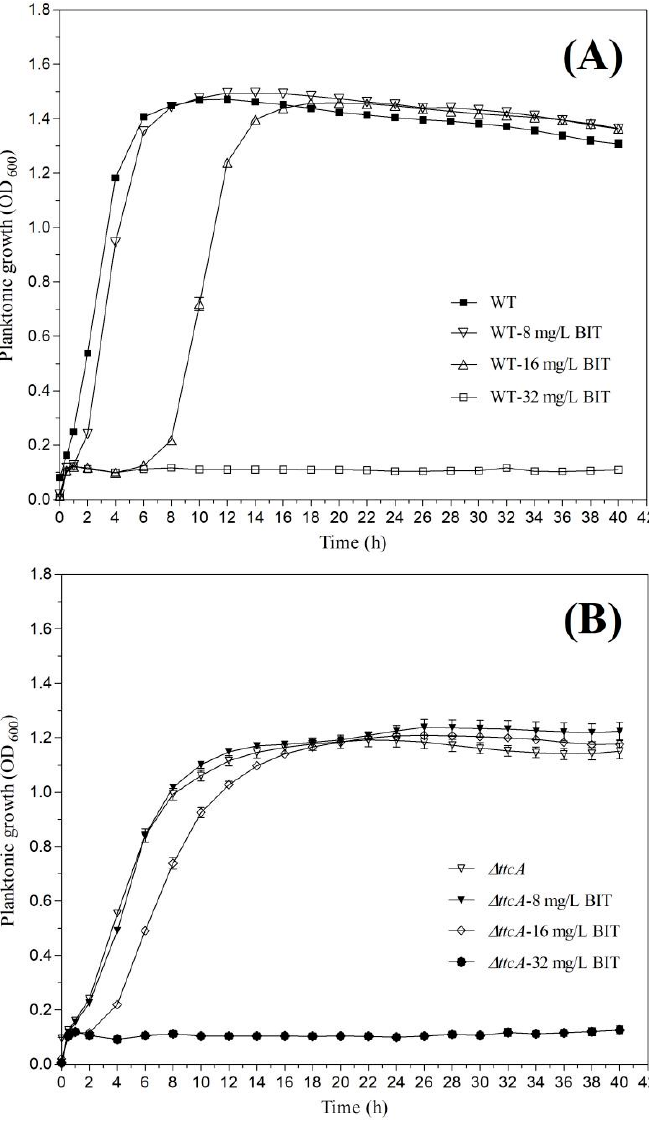
Figure 3. Cont. Figure 3.